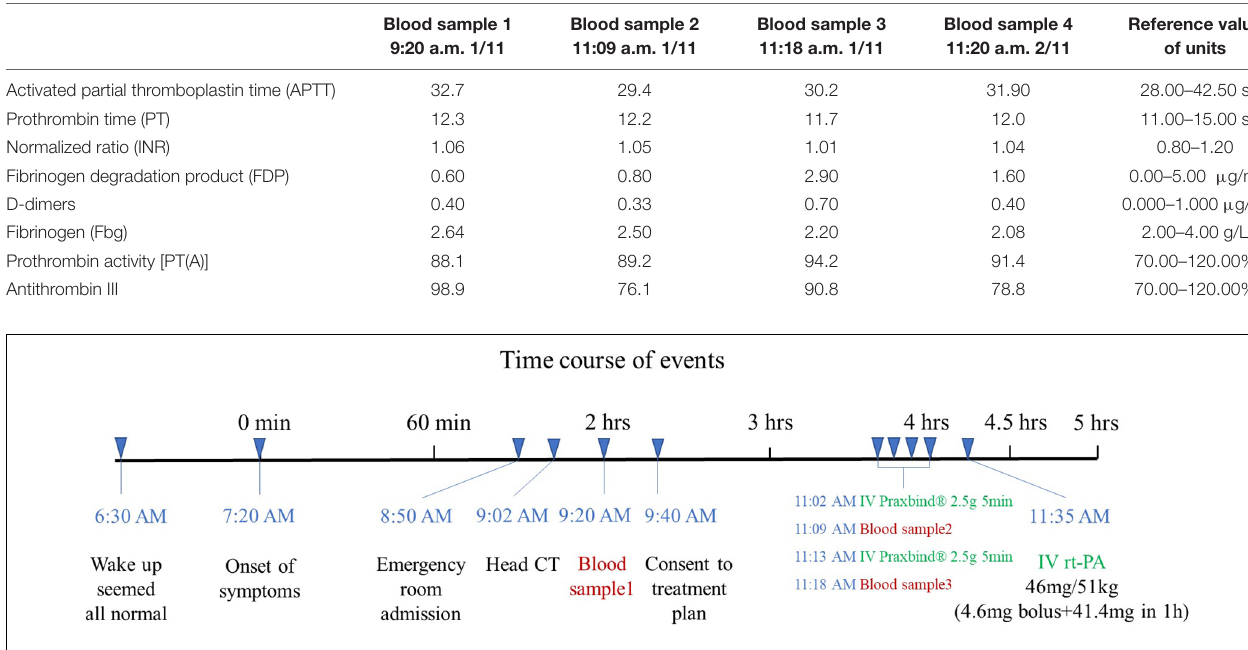
FIGURE 1 | Time course of